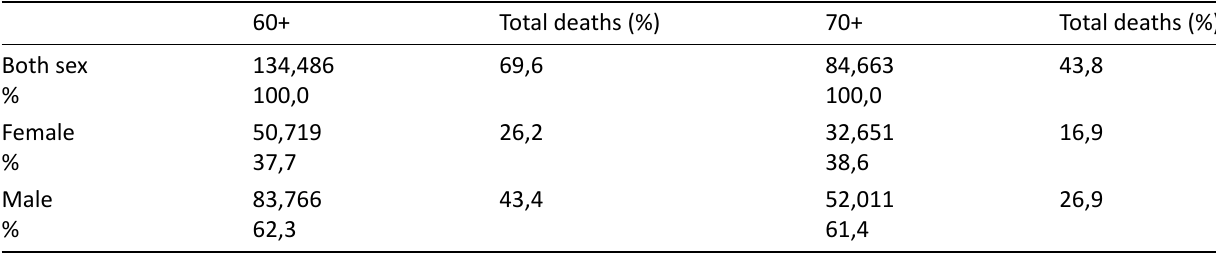
Table 1. Distribution of Covid‐19 deaths by age and gender (July